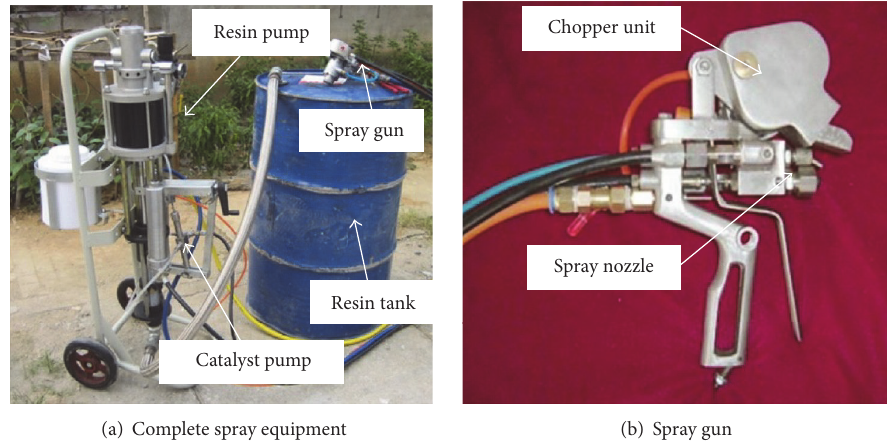
Figure 1: Special equipment of sprayed